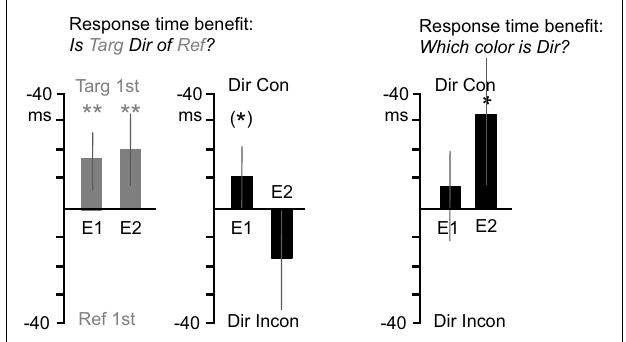
FIGURE 3 | Response time benefits for Experiments 1 and 2. The first graph (gray bars), depicts response times advantages for the “IsTarget Direction of Reference?” question type.Values toward graph top indicate faster responses for trials where the “target” object appeared first, and values toward graph bottom indicate faster responses for trials where the “reference” object appeared first. In the second graph (black bars), values toward graph top indicate faster responses for trials where object consistent with the directional term (e.g., the left object for “left” questions) appeared first, and values toward graph bottom indicate faster responses for trials of the opposite case.The third graph (black bars) depicts response time advantages for the “Which Color is Direction?” question type, using the same “direction consistency” analysis as the second graph. Asterisks indicate significant effects, an asterisk in parentheses indicates a marginal effect.